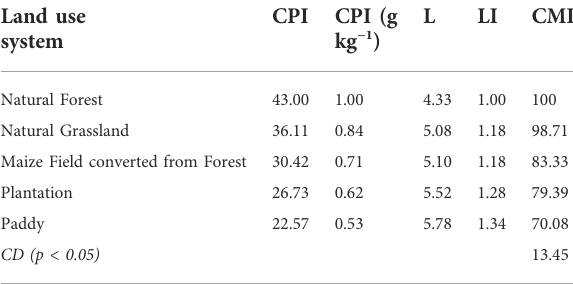
TABLE 4 Carbon Management Index under diverse land-use systems (0 – 40 cm).